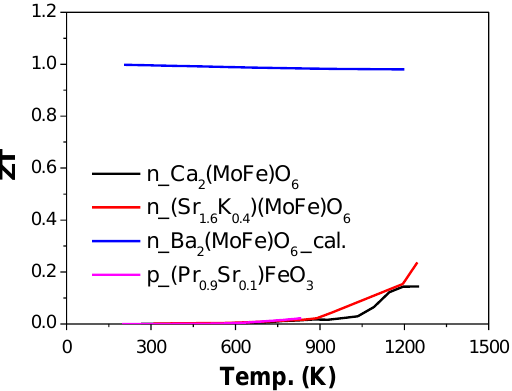
Figure 9. ZT value of AFeO 3 based oxide perovskite materials, the majority carrier types (n or p) were marked in the legend. The symbol “cal.” means the results come from the calculation.